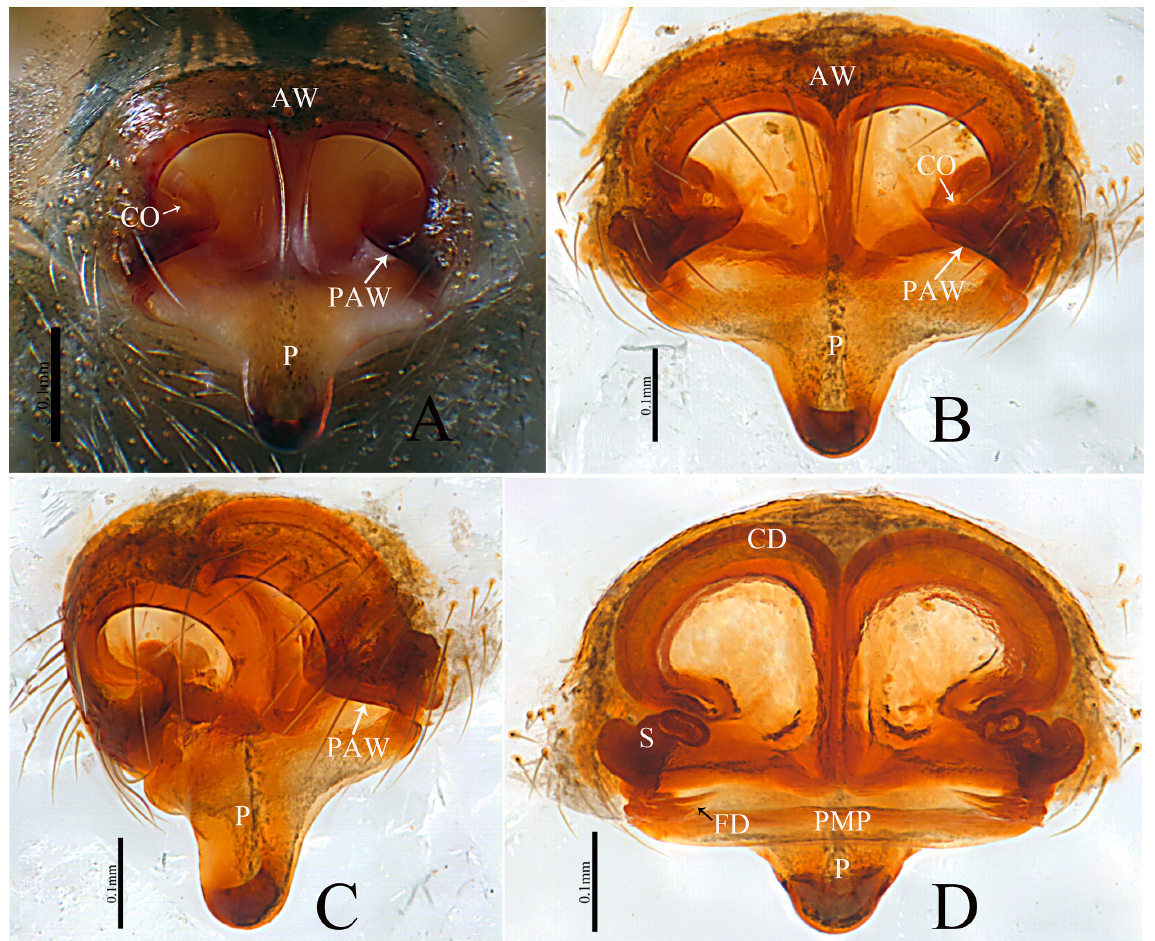
Fig. 13. Acroterius camur gen. et sp. nov., ♀, paratype (HNU-DHK–2002–038). A–B . Epigyne, ventral view. C . Epigyne, lateral view. D . Vulva, dorsal